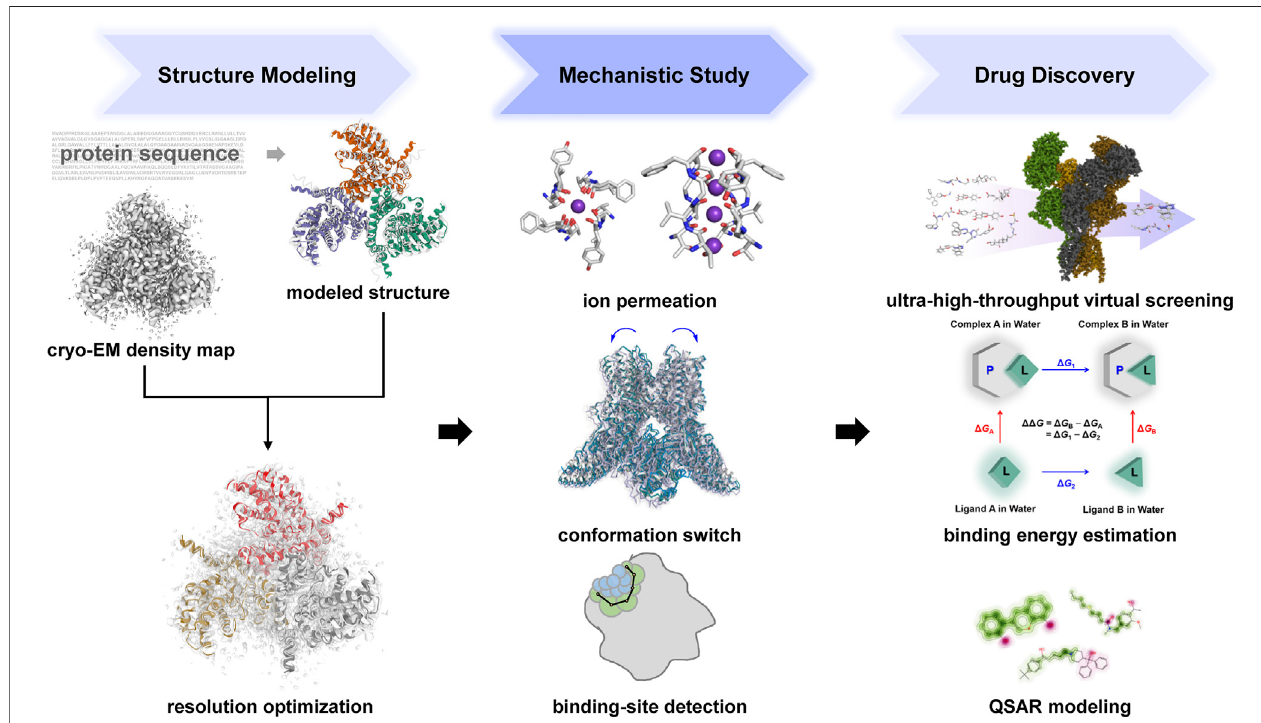
FIGURE 3 | Computational approaches in the structure modeling, mechanistic study and drug discovery of ion channels. Several subplots were collected using Hermite (https://hermite.dp.tech), Mol* viewer (Sehnal et al., 2021), PyMOL (https://github.com/schrodinger/pymol-open-source) and the Pred-hERG web-server (Braga et al.,